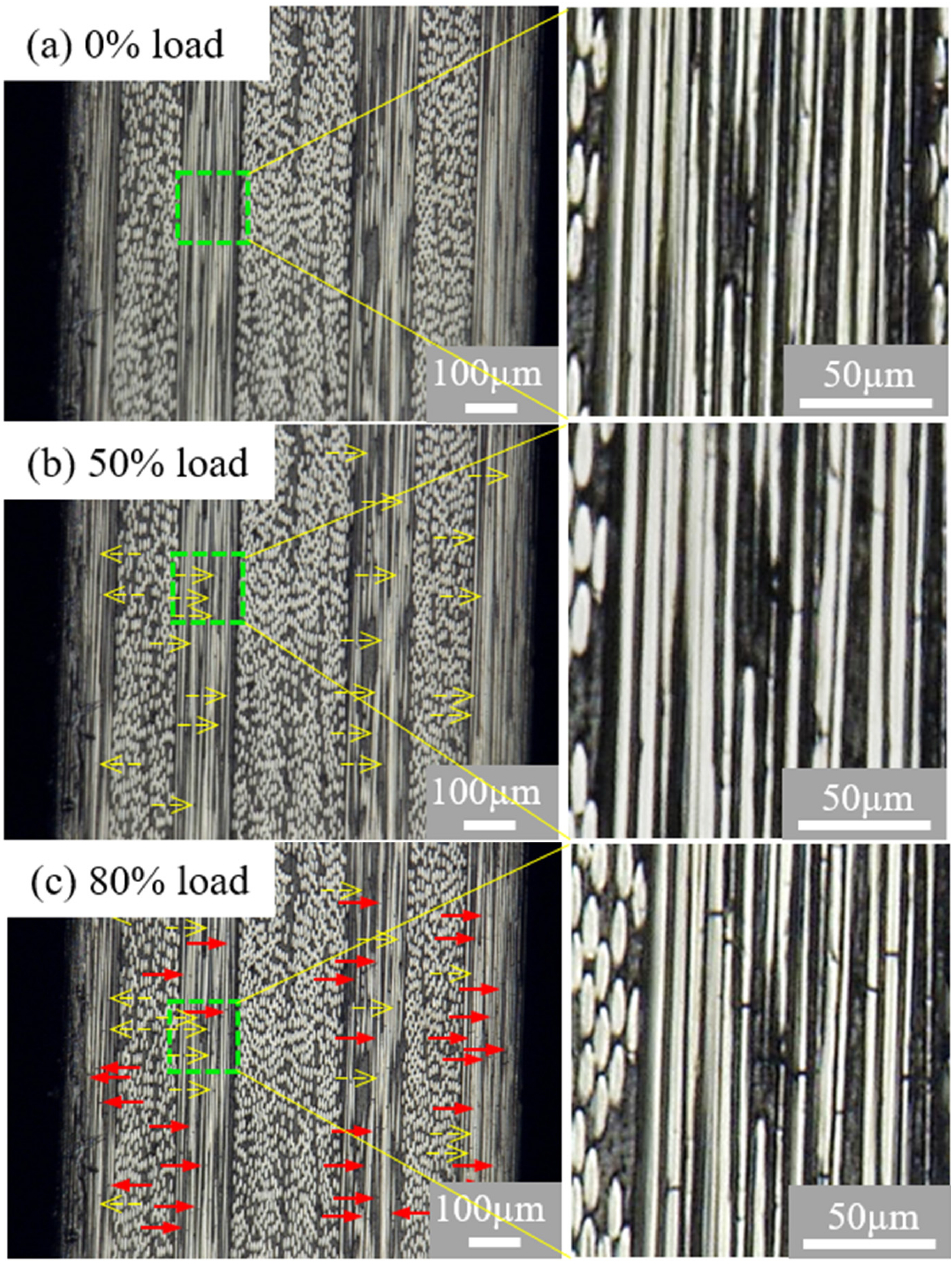
Figure 5. Damage images at the free edge of the [0/15] 2s laminates. ( a ) Before the test, ( b ) at 50% load, and ( c ) at 80% load. The dashed open arrows (yellow) refer to fiber breakages observed at 50% load; solid arrows (red) refer to new fiber breakages observed at 80%. The enlarged images are the green dashed regions.